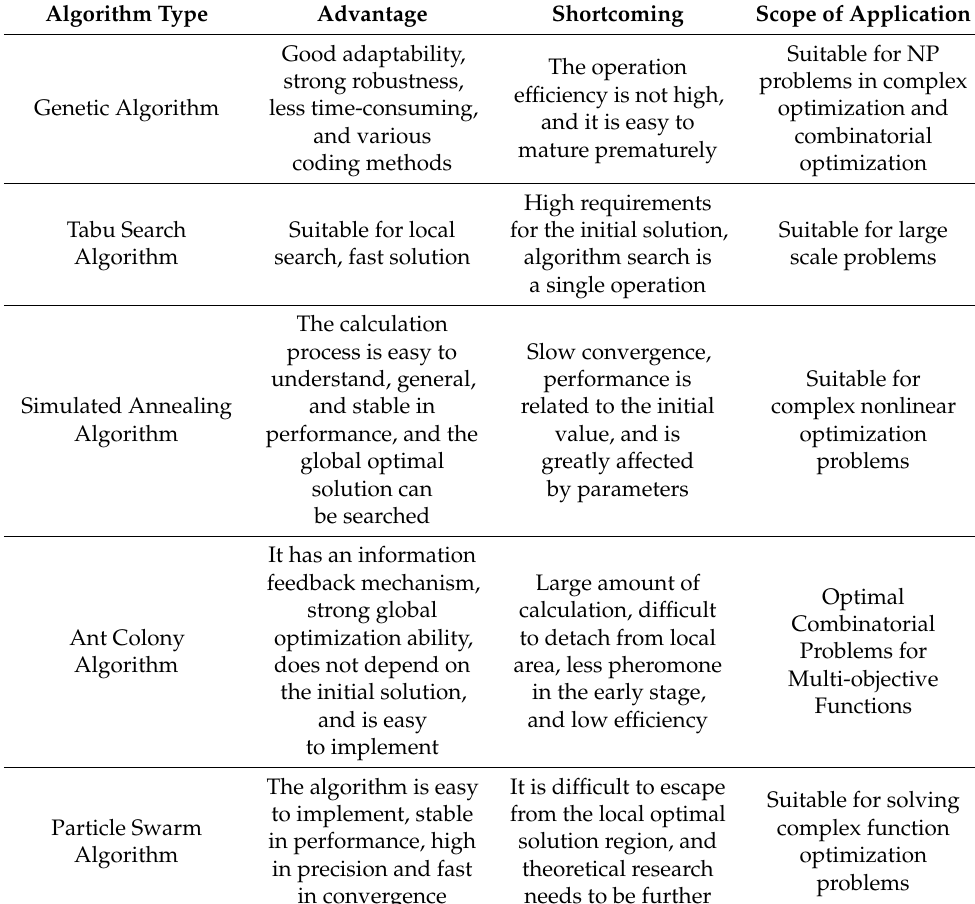
Table 5. A comparison of the common smart optimization